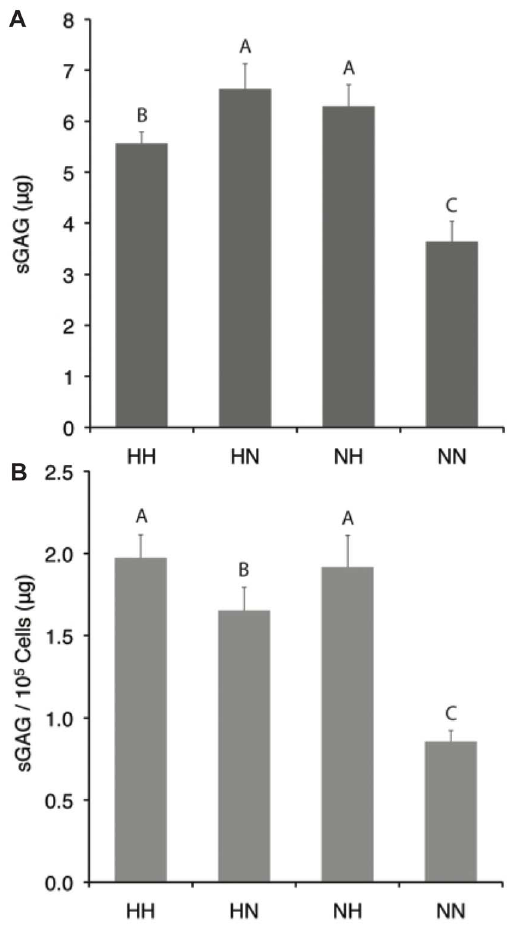
Figure 4. GAG accumulation during micromass culture. Cells exposed to hypoxia (HH, HN, NH) produced more GAG overall (A) and per cell (B) relative to continuous normoxic culture (NN) ( p , 0.05). Data are mean 6 S.D. Groups not connected by letters are significantly different.